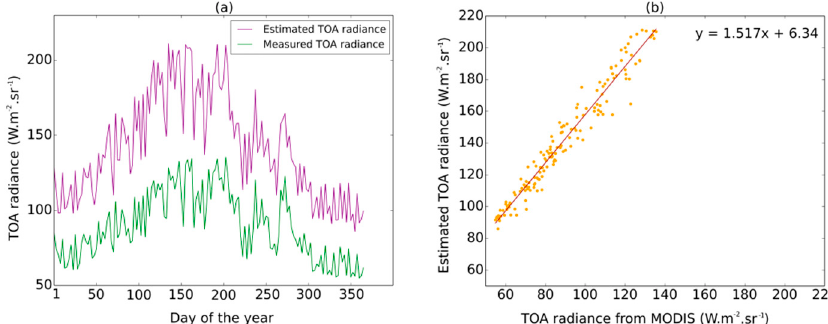
Figure 10. Comparison between TOA reflected radiance estimated using MODIS surface reflectance